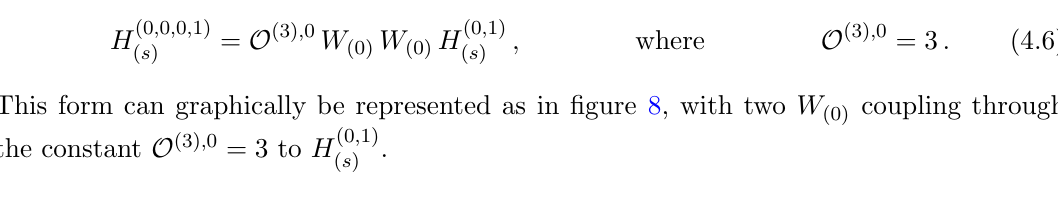
as two W coupling to H (0 ; 1) (0) ( s )